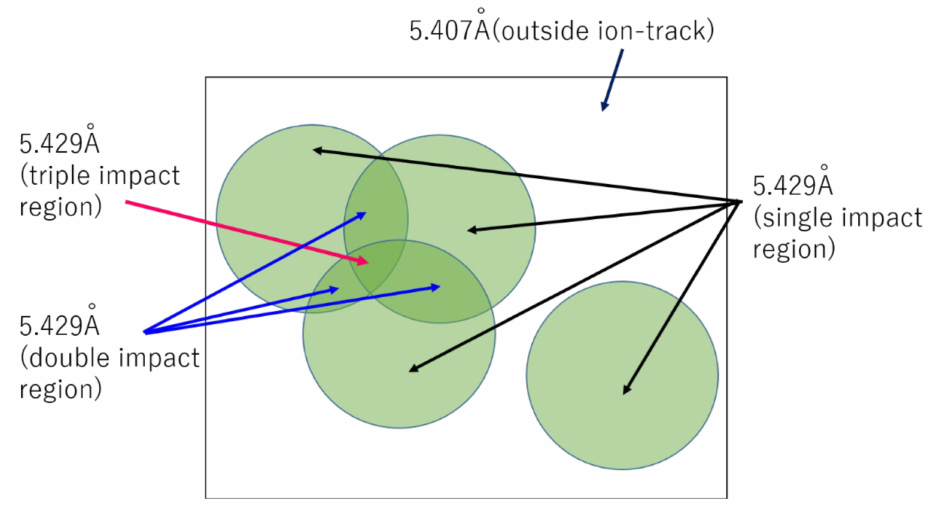
Figure 8. Schematic drawing of the e ff ect of ion-track overlapping on the lattice constant. The diameter, D , of the ion-track in which the lattice constant increases is estimated to be 4.7